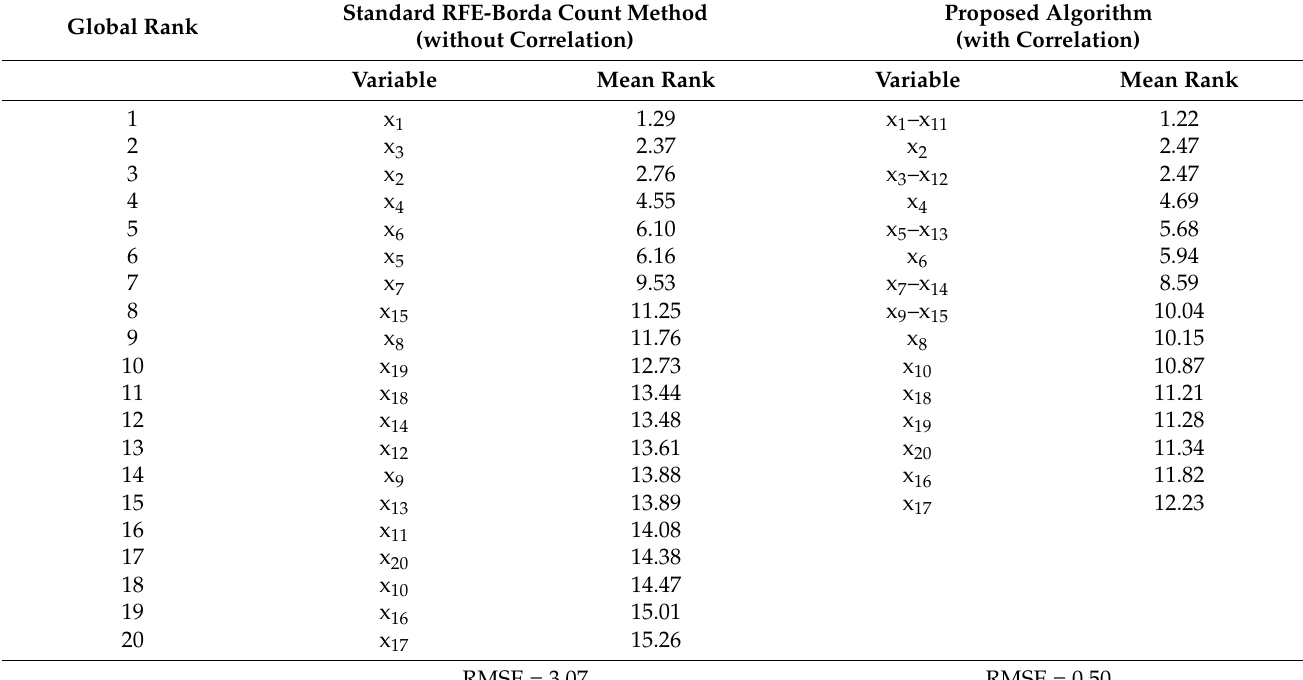
Table 4. Results of variable ranking for the representative simulated